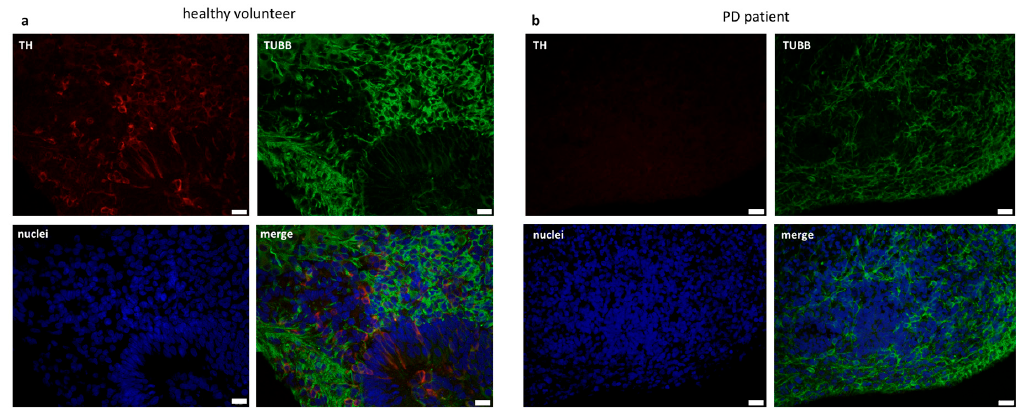
Figure 5. Differences in TH protein level in organoids from healthy volunteer and PD patient. The representative images show immunocytofluorescent staining for TUBB3 and TH in organoids ( a ) TUBB3 and TH is expressed in control organoids on day 39. White scale bar, 20 µ m. ( b ) PD organoids express TUBB3 and do not express TH on day 39. White scale bar, 20 µ m. TUBB3—beta-III-tubulin (green), TH—tyrosine hydroxylase (red), Hoechst (blue).